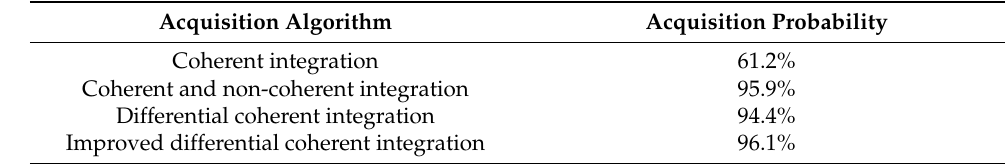
Table 3. Acquisition probability statistics of four algorithms for authentic